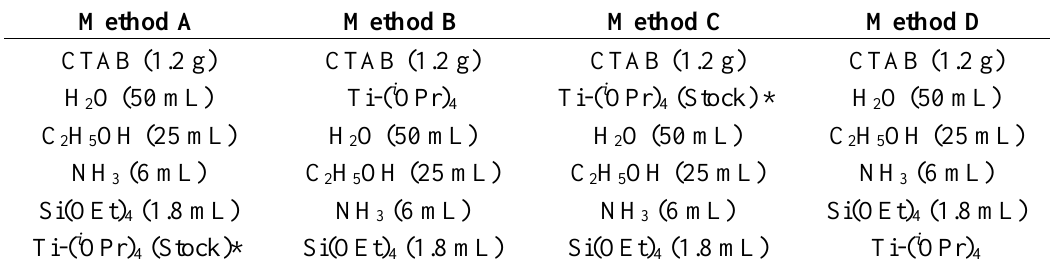
Table 2. Preparation of TiO 2 -MCM-48 by different